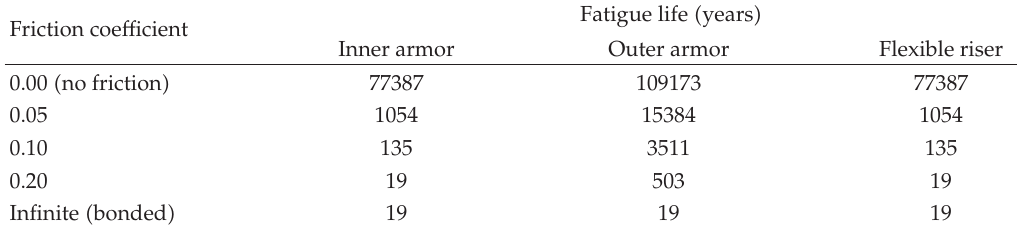
Table 3: Fatigue life: e ff ect of di ff erent friction coe ffi cients.